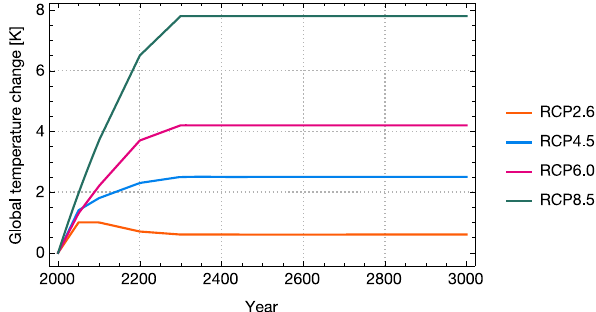
Figure 4. Global annual mean surface air temperature anomalies for different representative concentration pathways (IPCC, 2013; Ta- ble 12.2). After 2300 the temperature anomalies are kept